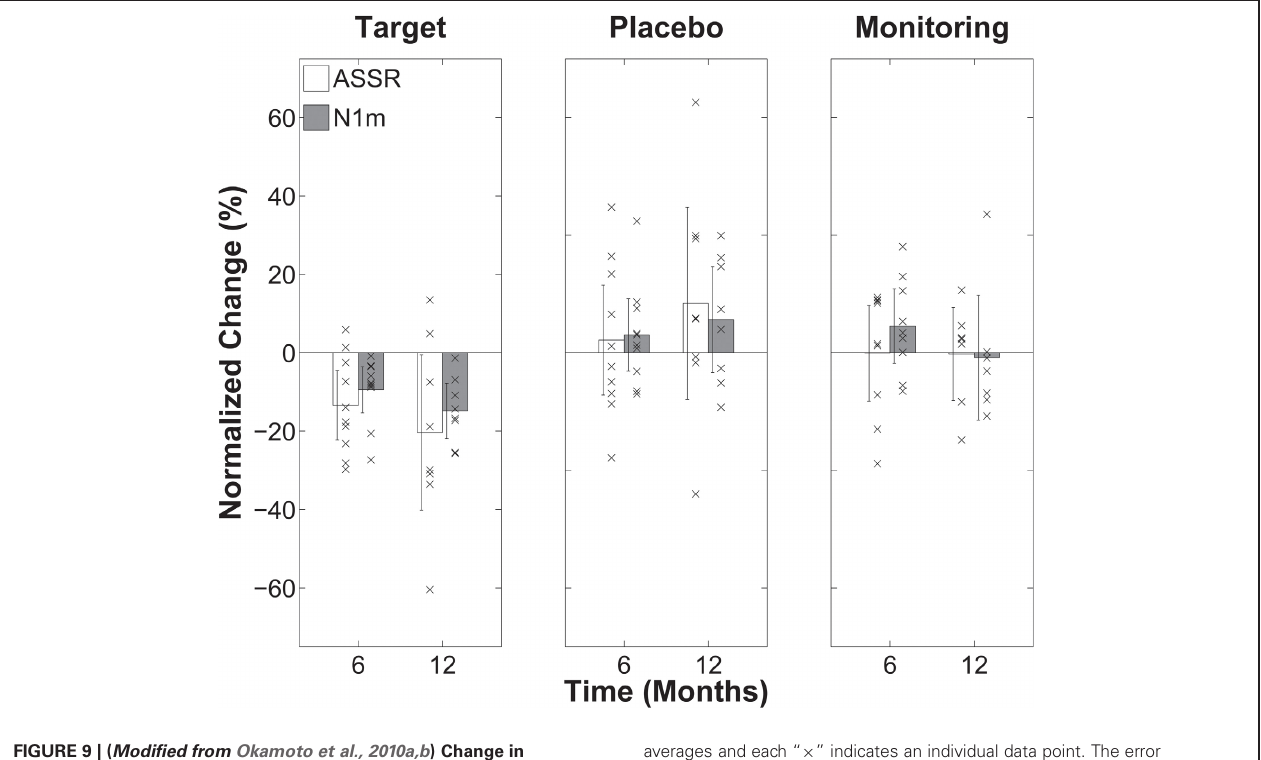
FIGURE 9 | ( Modified from Okamoto et al., 2010a,b ) Change in normalized tinnitus-related auditory cortical evoked activity after 6 and 12 months of treatment (or monitoring) relative to baseline ( = 0) for the three patient groups (target TMNMT, placebo TMNMT, and monitoring). Positive change values reflect increase in activity; negative change values reflect decrease in activity. The bars indicate group